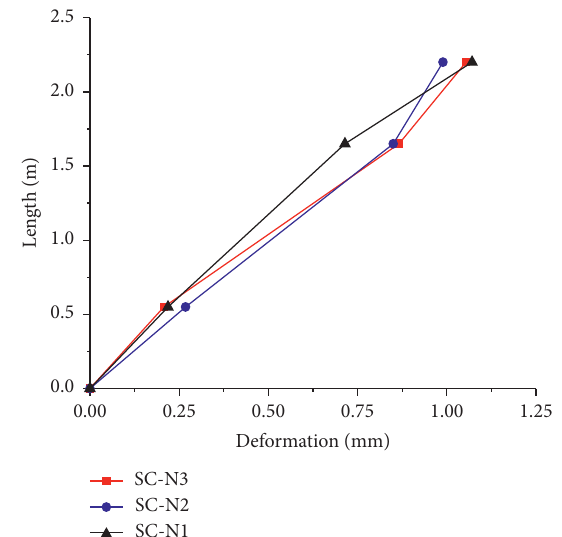
Figure 26: Load-deformation relationship at different heights.